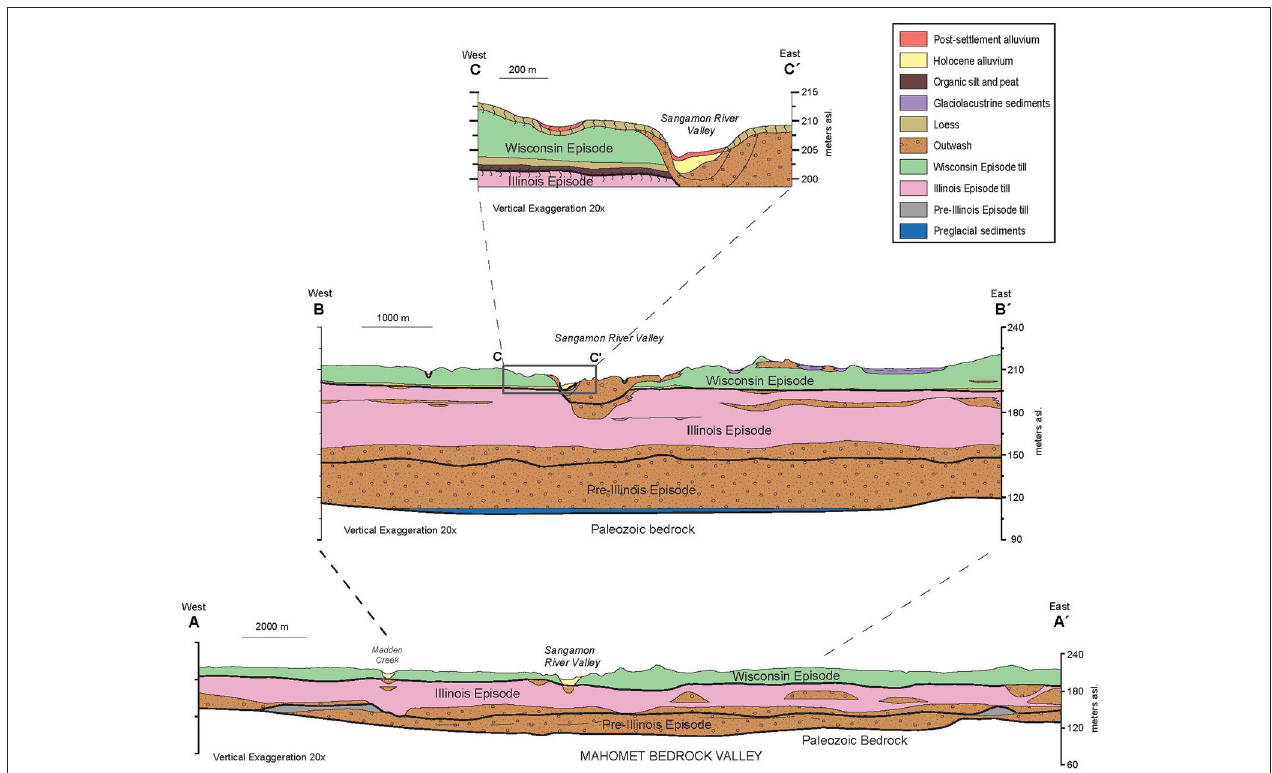
FIGURE 5 | Structure of the CZ in in the USRB. (A,A ′ ) Geologic cross section across the MBV showing stacked, laterally extensive till units from multiple glacial events with less extensive, isolated coarse-grained unites in the subsurface and in modern valleys. Modified from Stumpf and Atkinson (2015). © 2015 University of Illinois Board of Trustees. Used by permission of the Illinois State Geological Survey. (B,B ′ ) Geologic cross section over the western half of the MBV showing divisions with tills from multiple events, two generations of coarse-grained deposits stacked in the Sangamon River Valley and glacio-lacustrine deposits in the near surface at the eastern end of the cross-section. Modified from Grimley et al. (2016b). © 2016 University of Illinois Board of Trustees. Used by permission of the Illinois State Geological Survey. (C,C ′ ) Geologic cross section crossing the Sangamon River Valley showing loess draping the current land surface and a portion of an ancient CZ from a previous interglacial preserved beneath Wisconsin Episode till, loess, and peat. Post-settlement alluvium is present within depressions on the upland and above Holocene alluvium. The dominant depositional processes throughout the Pleistocene have been associated with the glaciations. Yet late-glacial and postglacial processes causing river dissection and sedimentation in river valleys have also impacted the structure of the